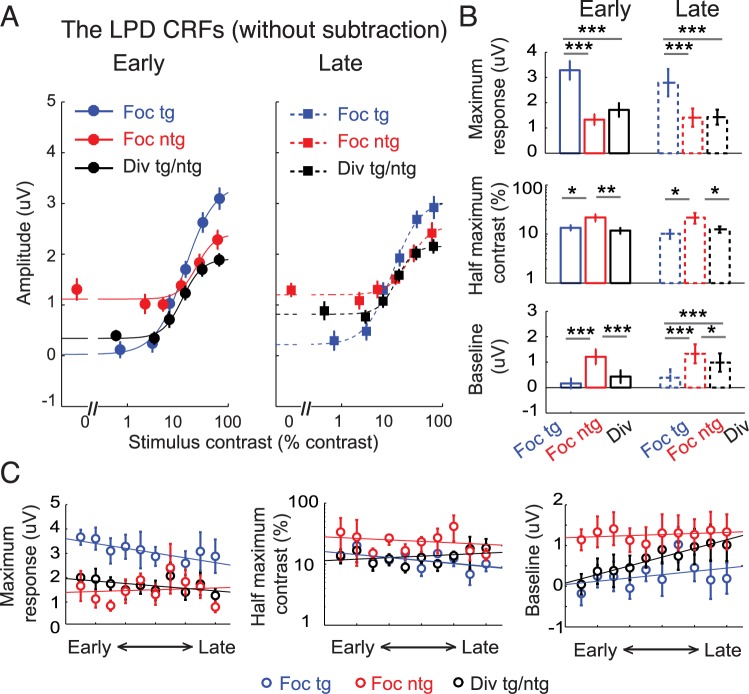
Modulations of the late positive deflection (LPD) component without baseline subtraction.(A) The LPD contrast response functions (CRFs), based on event-related potentials (ERPs) without baseline subtraction. Note that the contrast values on the x-axis are not exactly the same across target and nontarget conditions because in the target conditions, we used the averaged contrast values between the pedestal and incremental stimuli. Error bars represent within-subject SEM. (B) Corresponding maximum response (response at 100% contrast minus baseline), half-maximum contrast, and baseline parameters. Error bars represent the 68% CIs; *, **, and *** represent significant pairwise comparisons between attention conditions in each training phase, with p < 0.05 and p < 0.001, respectively. (C) The day-by-day analysis of the LPD data without baseline subtraction (2 electroencephalography [EEG] sessions or ~1 day per each time bin). Left, middle, and right panels represent the estimated maximum response, half-maximum contrast, and baseline parameters, respectively. Error bars represent 68% CIs. Data are available from the Open Science Framework (https://osf.io/pc7dr/).